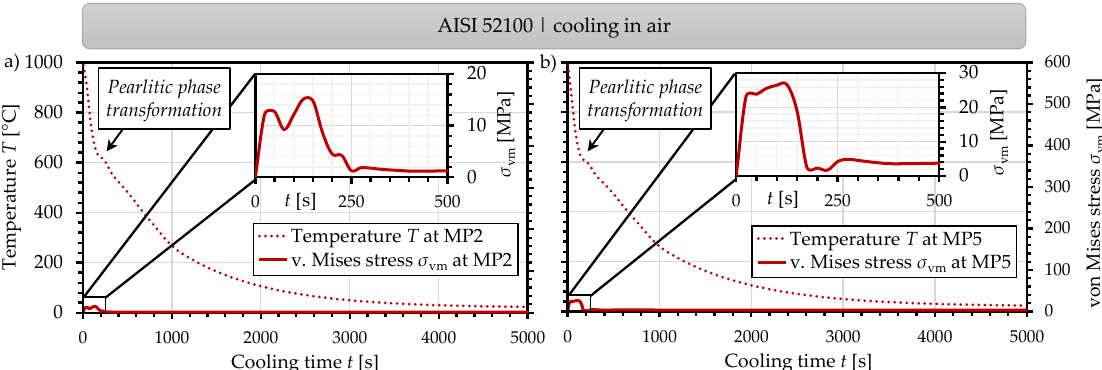
Figure 9. Temporal development of the temperature and von Mises stress at MP2 ( a ) and MP5 ( b ) during the cooling of AISI 52100 in air.